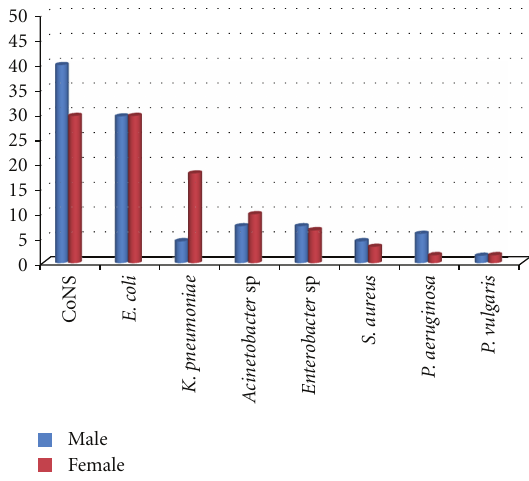
Figure 1: Frequency and distribution of bacterial isolates from blood cultures. CoNS ∗ : Coagulase-Negative Staphylococci.